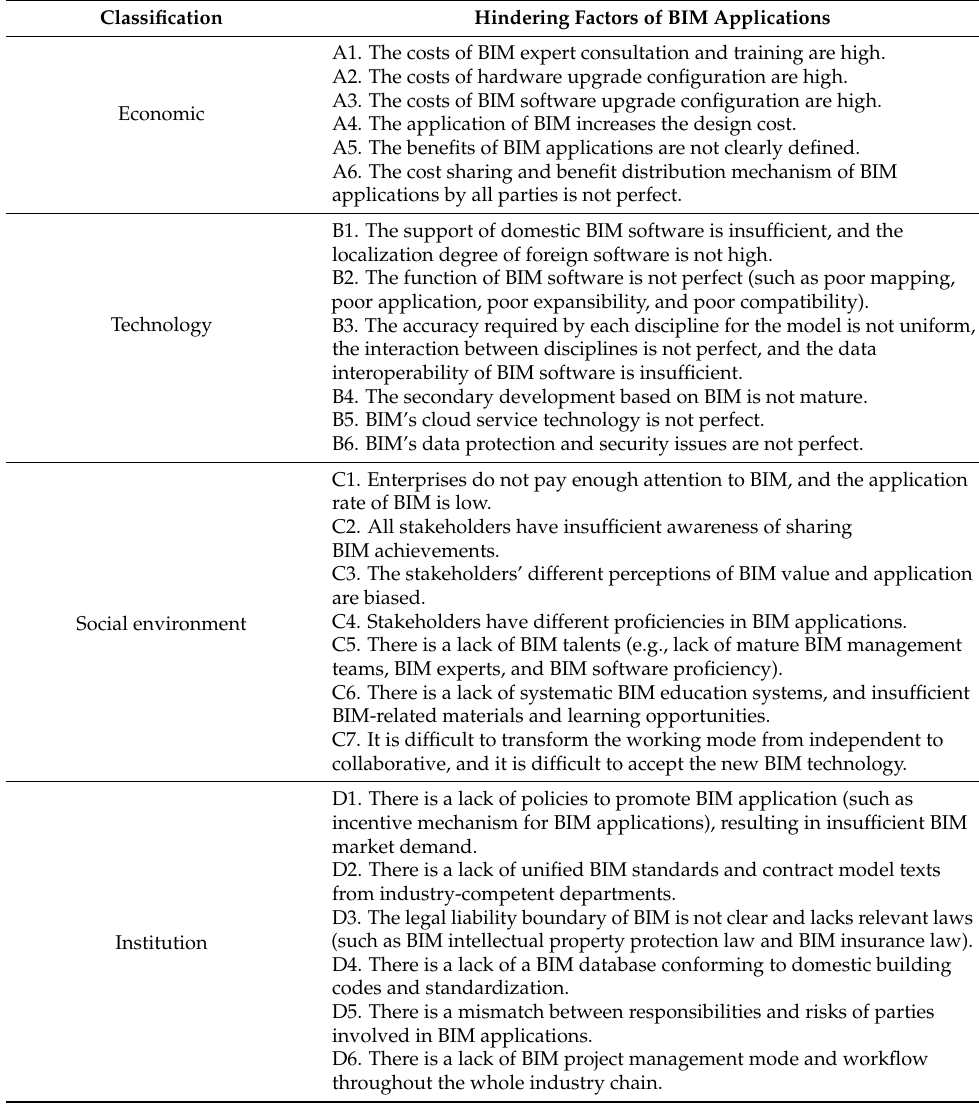
Table 2. Classification of hindering factors of BIM